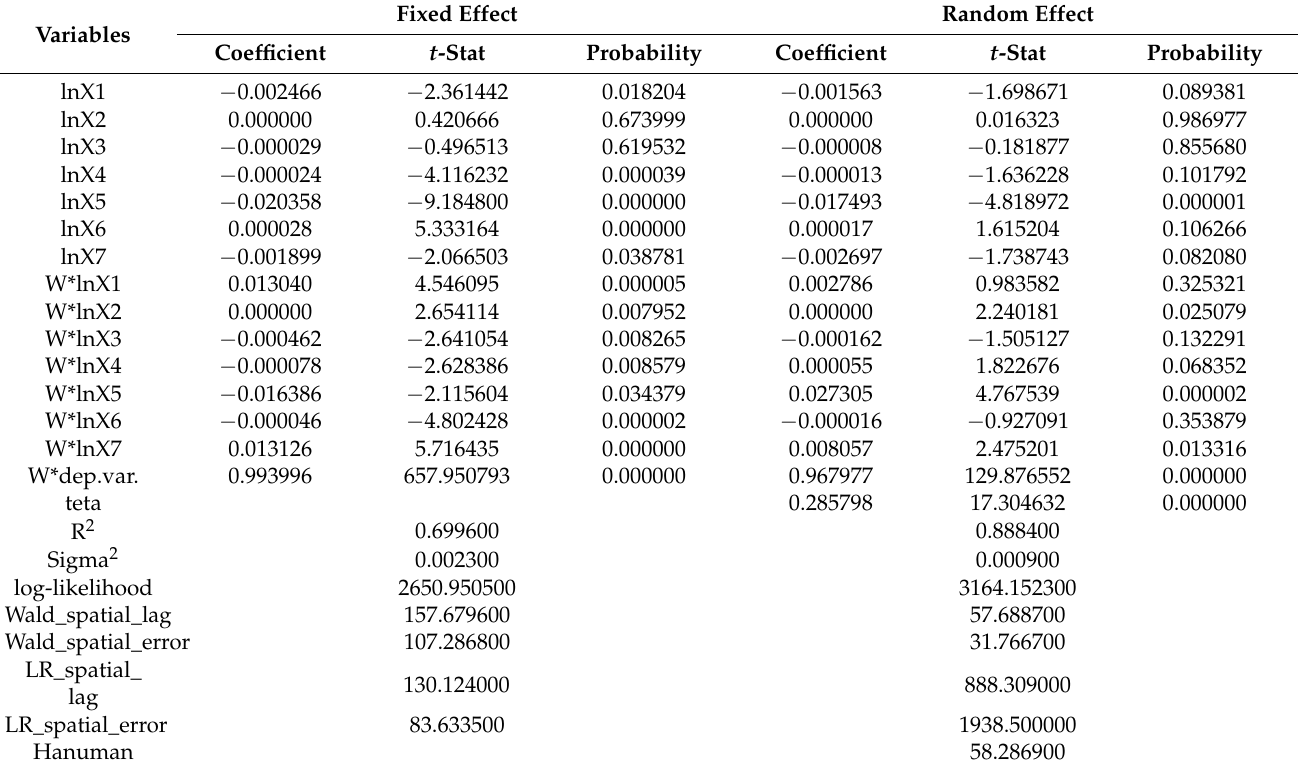
Table 8. Estimation results of Durbin evaluation model for urban human settlements